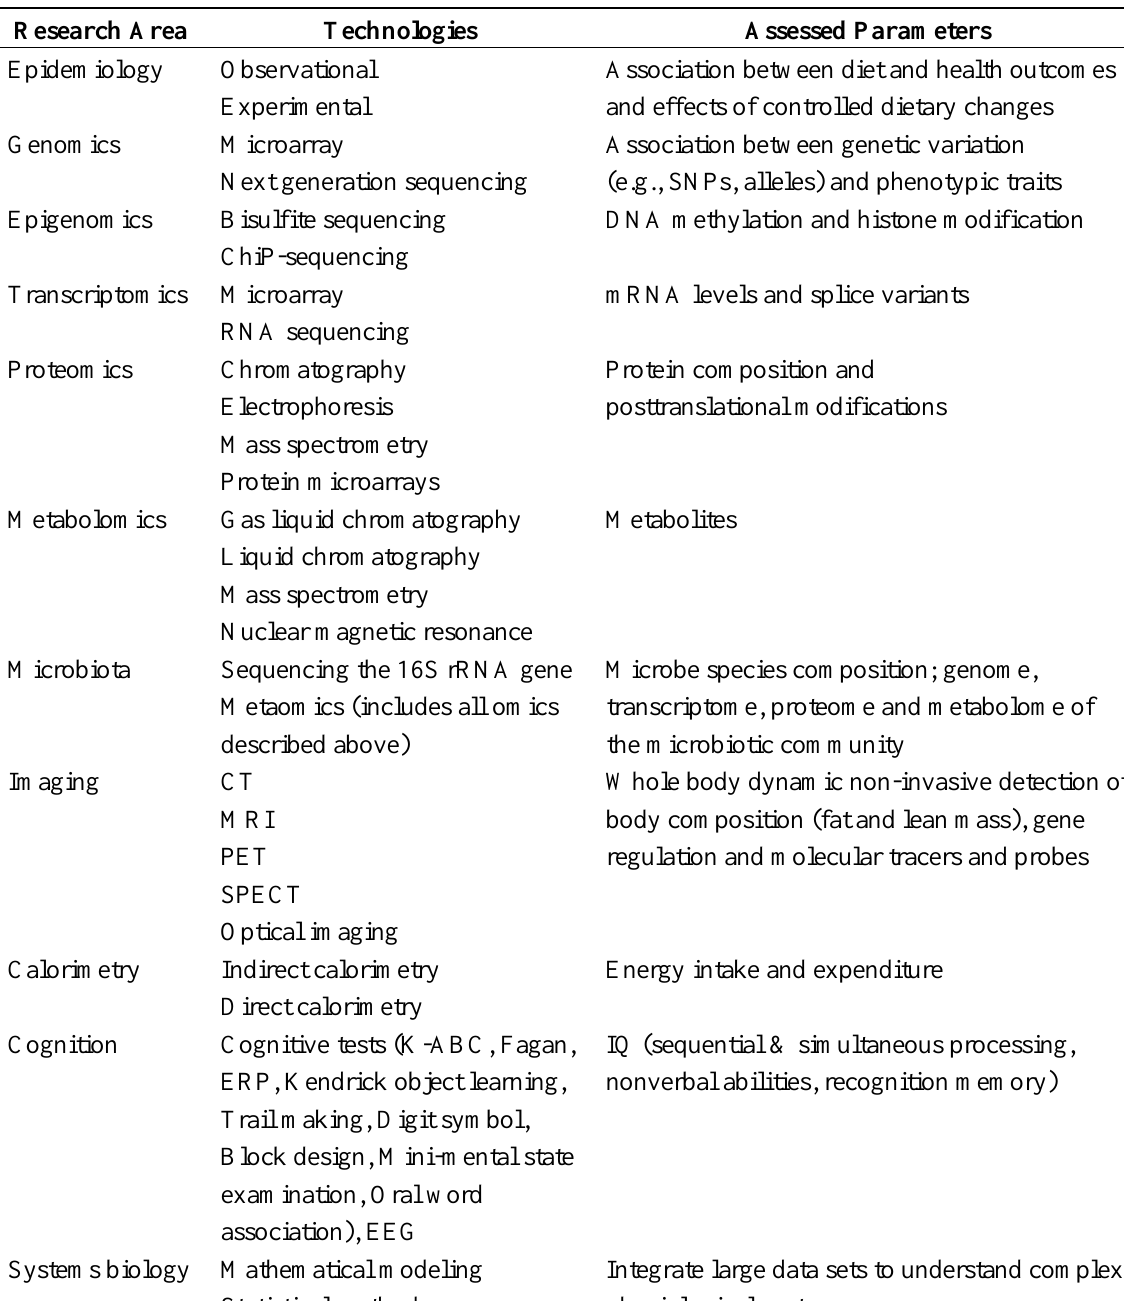
Table 2. Methods in nutritional